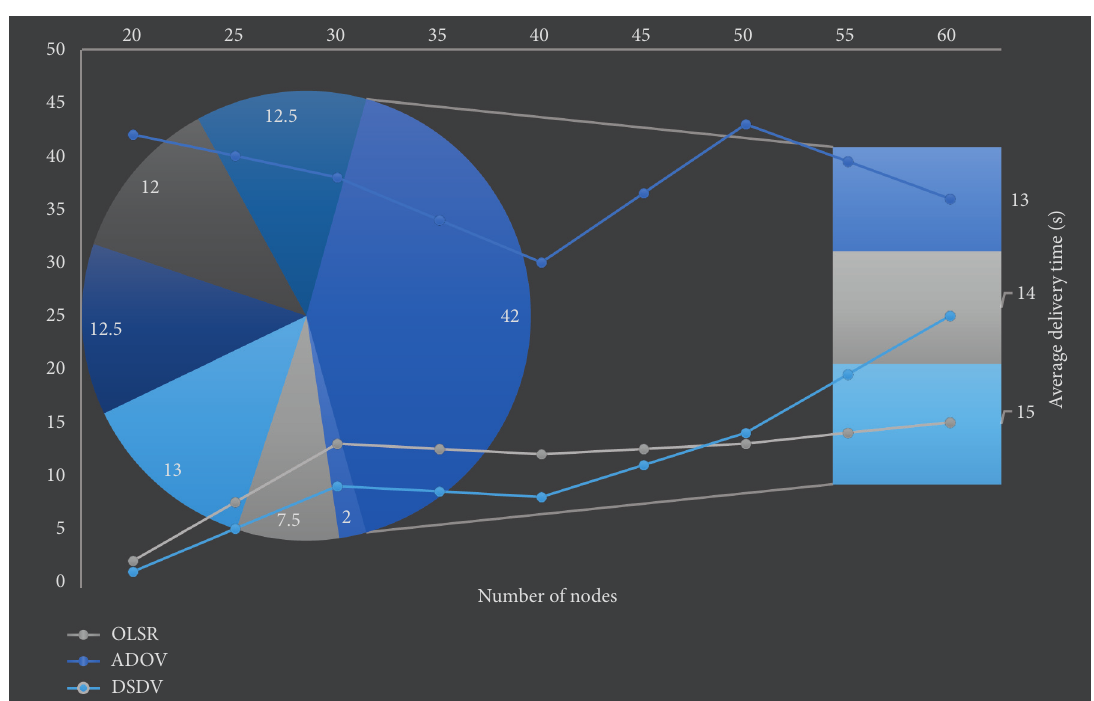
Figure 4: The comparison of average